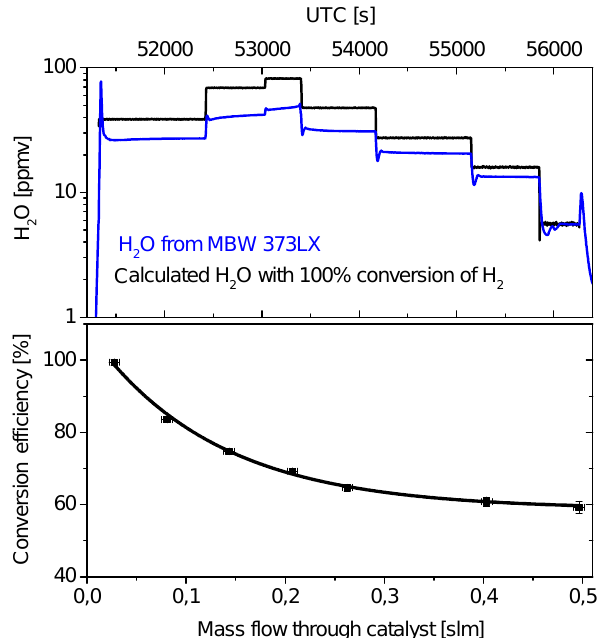
Figure 4. Performance of the calibration source with respect to the MBW 373LX reference instrument. The upper panel shows the ex- pected H 2 O mixing ratio calculated from the H 2 concentration in the gas cylinder and the gas flow through the catalyst assuming a complete conversion of every H 2 molecule into H 2 O (black line). The blue line is the H 2 O mixing ratio which was simultaneously measured by the dew point mirror. From the discrepancy between both lines we can calculate the conversion efficiency (CE) of the catalyst. The CE decreases with increasing flow through the cata- lyst and is fitted with an exponential